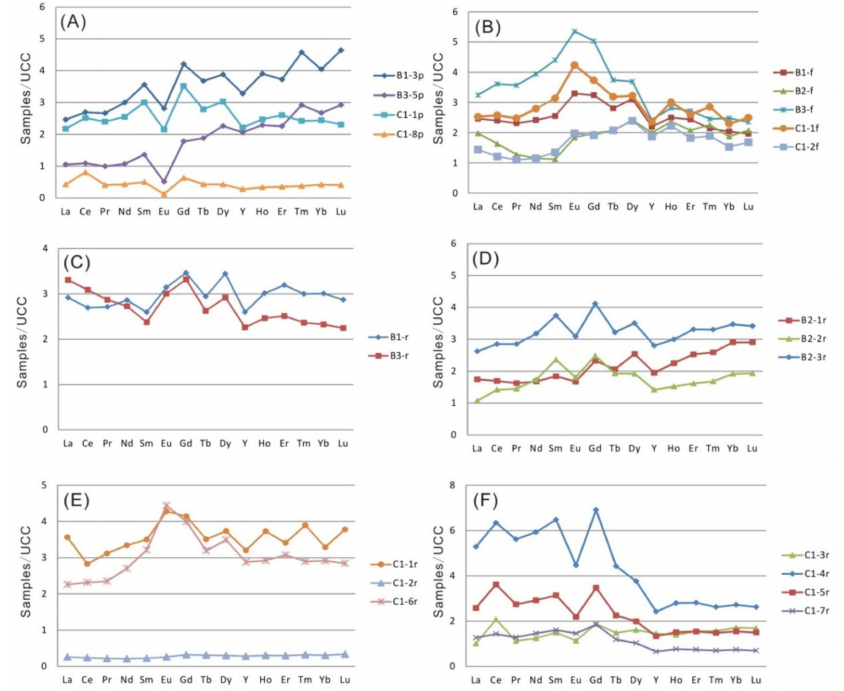
Figure 21. REY distribution patterns in the roof, floor, and parting strata of B1, B2, B3, and C1 coals. REY are normalized to an Upper Continental Crust (UCC) [87]. ( A ), parting samples in C1 Coal and B1 and B3 layers. ( B ), Floor samples of C1 Coal and B1, B2, and B3 layers. ( C ), Roof samples of B1 and B3 layers. ( D ), Roof samples of the B2 layer. ( E , F ), Roof samples of C1 Coal.